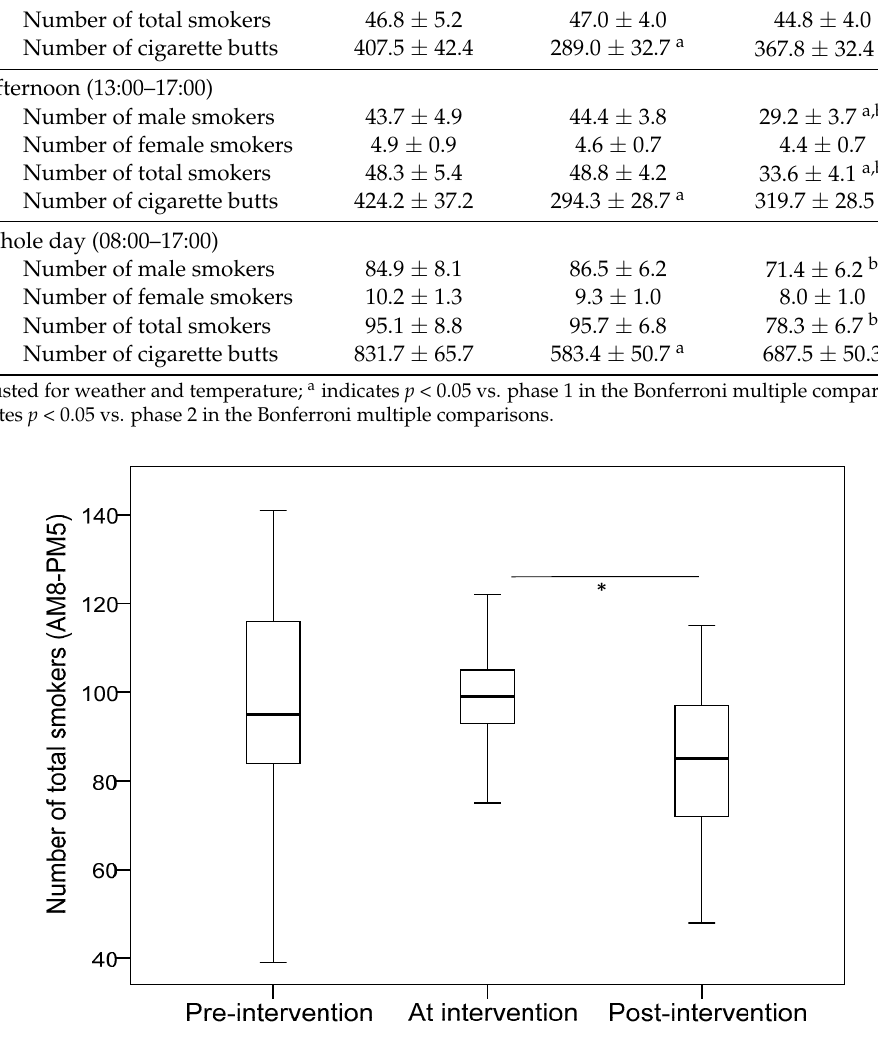
Table 1. Effect of smoking reduction education on the number of smokers and cigarette butts outside of the target hospital.